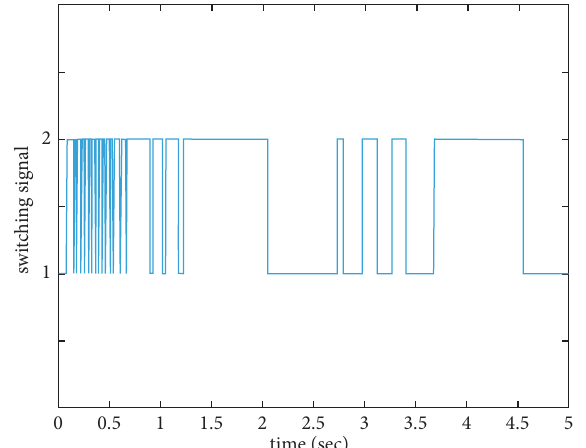
Figure 2: The switching signal of System (35) without inputs